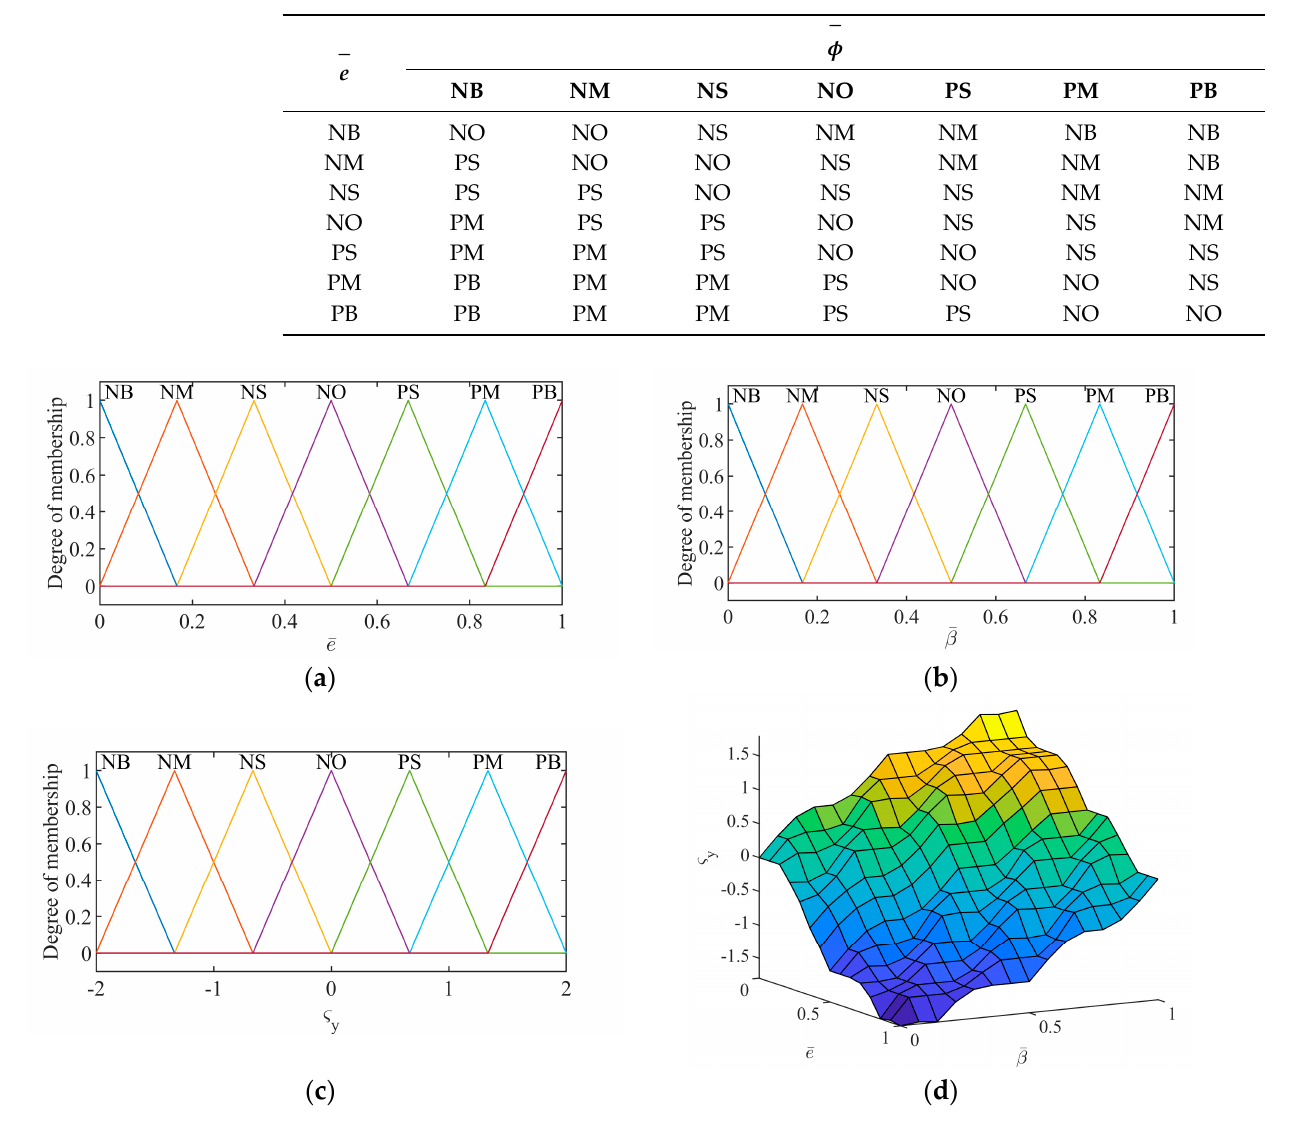
Table 2 . Fuzzy control rules of Table 3. Fuzzy control rules of ς φ .